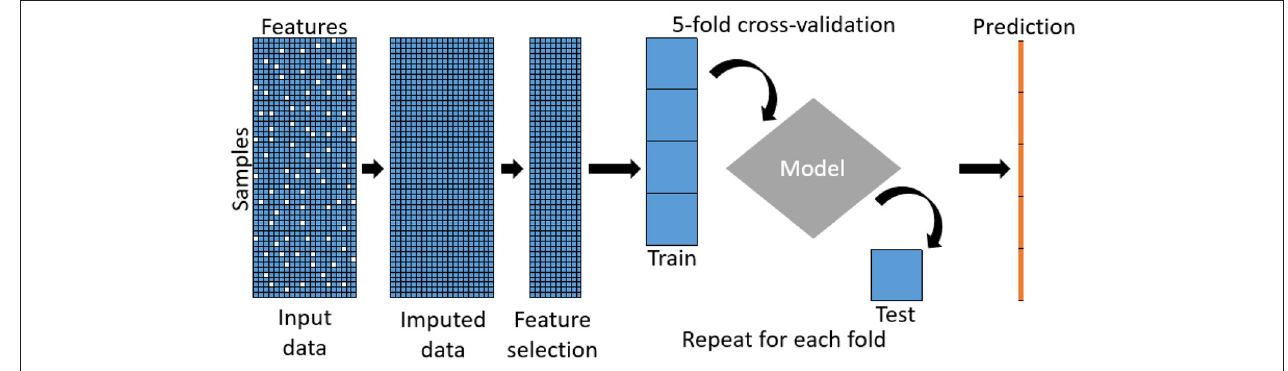
FIGURE 7 | Pipeline of the predictive